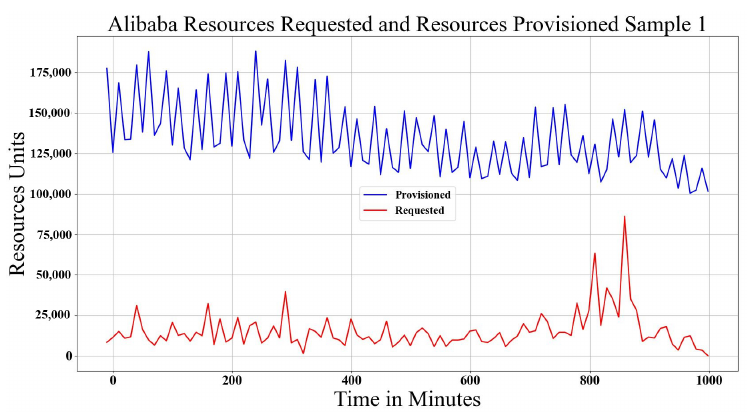
Figure 5. Alibaba data center Provisioned and Requested Resources, Sample 1.